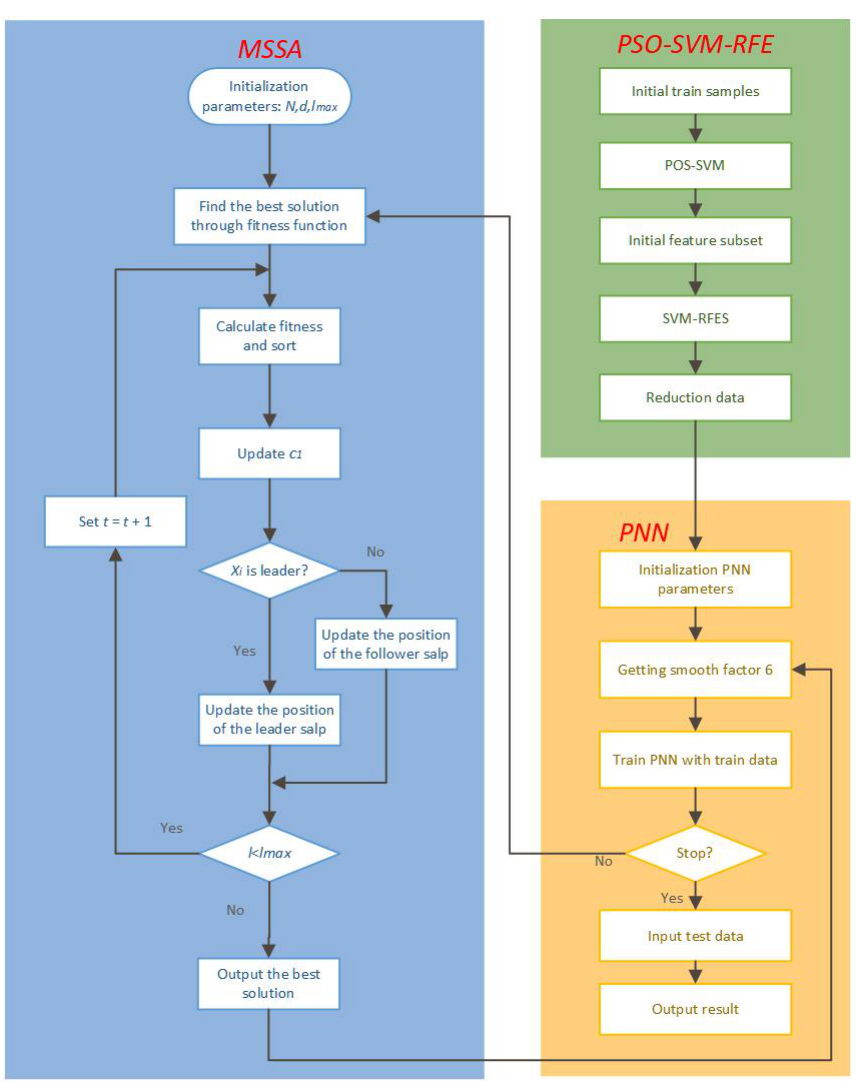
Figure 3. The proposed PSO-SVM-RFE-MSSA-PNN method for fault